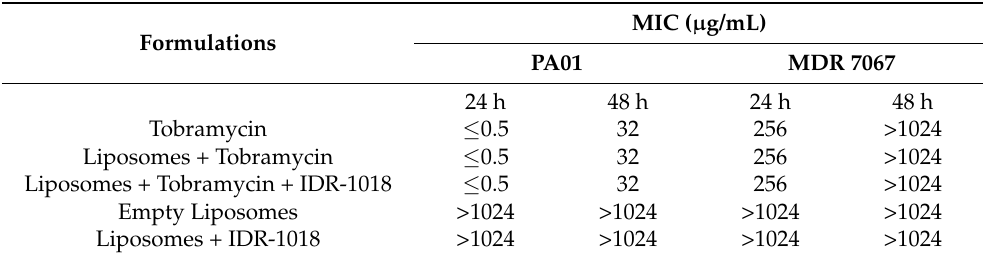
Table 3. PA01 and MDR 7067 P. aeruginosa planktonic strains are susceptible after 24 h exposure (i.e., MIC) and 48 h exposure after biofilm-grown isolates (i.e., BIC) to free tobramycin, tobramycin-loaded liposomal formulations, empty liposomes, and peptide-loaded